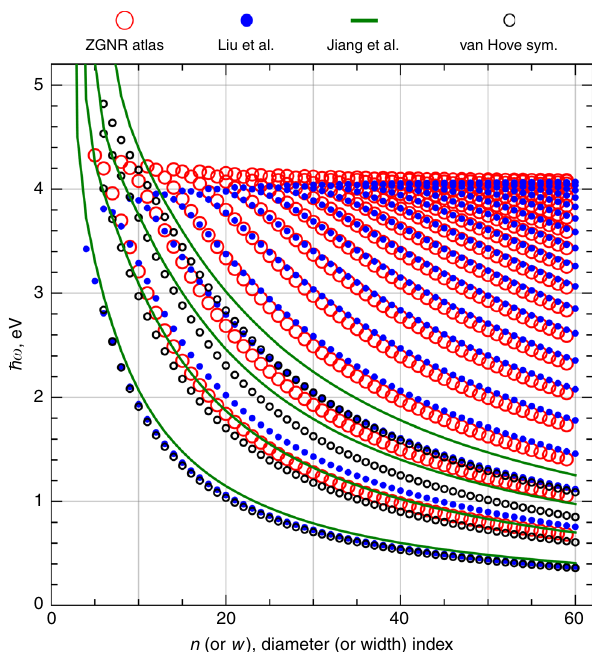
Fig. 5 An atlas of ZGNR bulk optical resonances. Optical resonances of the ZGNR atlas (large red open circles) obtained by linear mapping of the armchair SWCNT resonances (small blue fi lled circles) given by interpolating formula from Liu et al. 11 . The fi tting formula from Jiang et al. 49 (green solid curves) is added, as well as the energy differences (small open black circles) between the van Hove singularities symmetrically placed with respect to the Fermi level of ZGNRs (van Hove sym.) calculated based on ZGNR (av.) TBM from Table